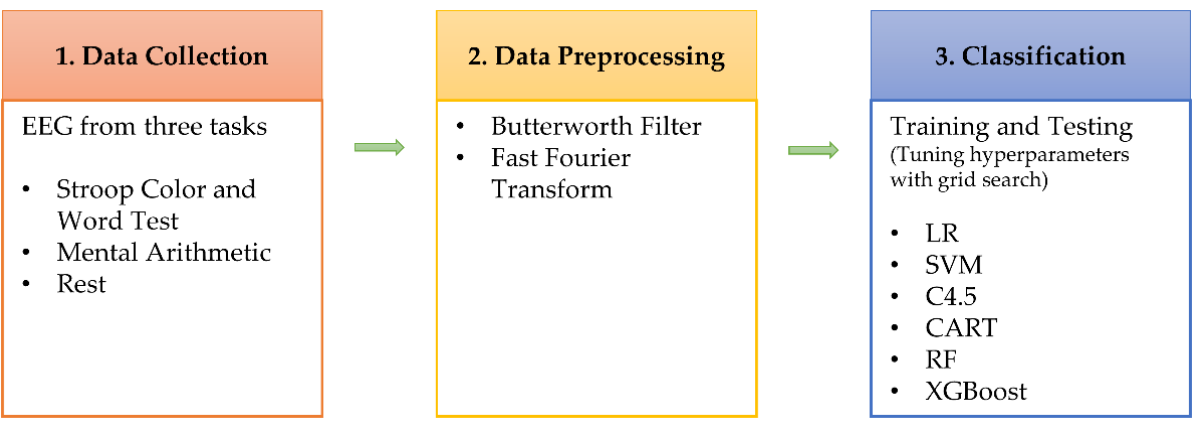
Figure 1. Diagram for the research flow.